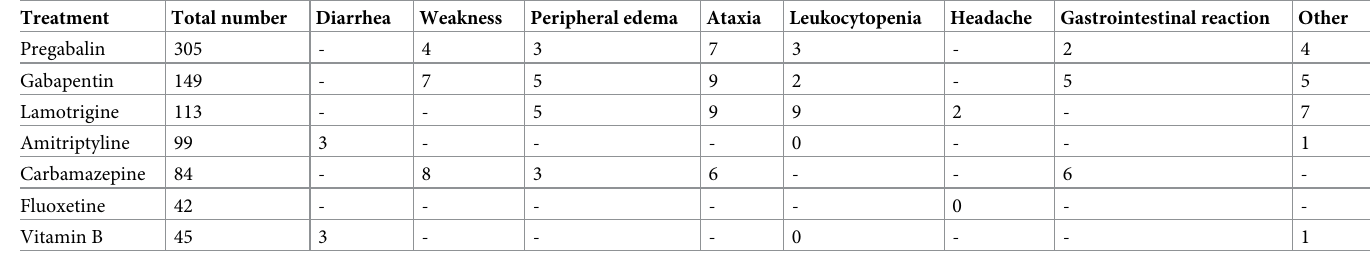
Table 4. Analysis of adverse reactions (number of events).